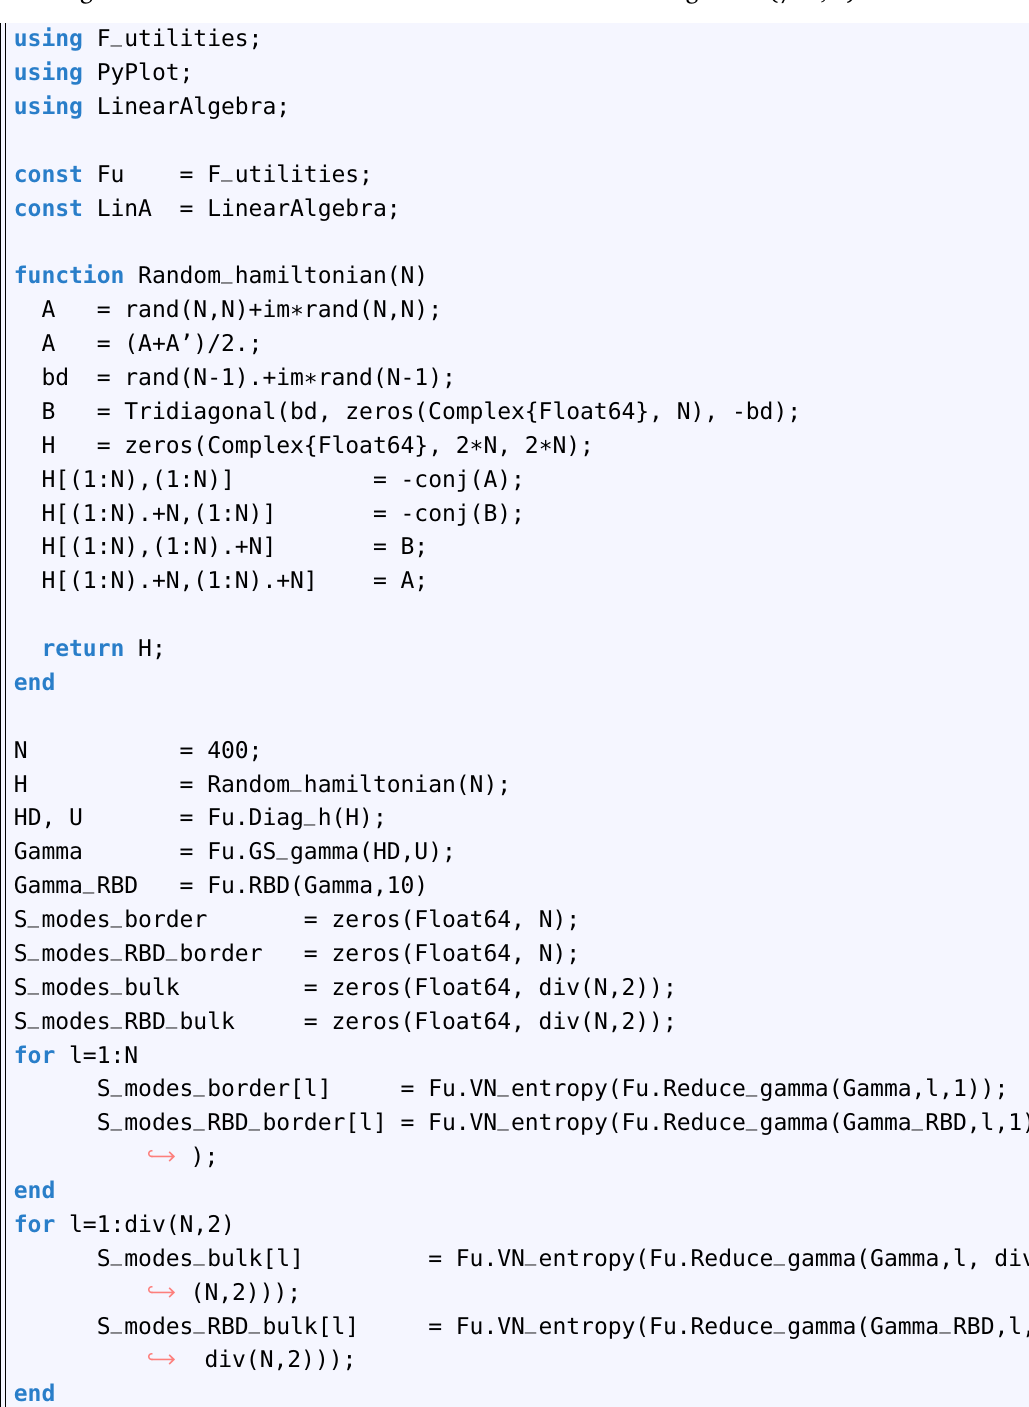
Figure 13: Eigenvalues different from 0 and 1 for different partitions of the system for the ground state Γ of a hopping Hamiltonian of a system of N = 400 sites, and for Γ with bond dimension reduced to m . The blue dots correspond to partitions of Γ with first site at the boundary of the system and with dimension (cid:96) . The orange dots correspond to partitions of Γ with first site at the boundary of the system and with dimension (cid:96) . The green dots are anologous to the blue dots, but computed for the state Γ ( m = 5 ) obtained reducing the bond dimension of Γ to m = 5. Red dots are analogous to the orange dots, but computed for Γ ( m = 5 ) . As expected the number of eigenvalues different from 0 and 1 are bounded as # eigenval ( (cid:54) = 0,1 ) ≤ 2 m . using